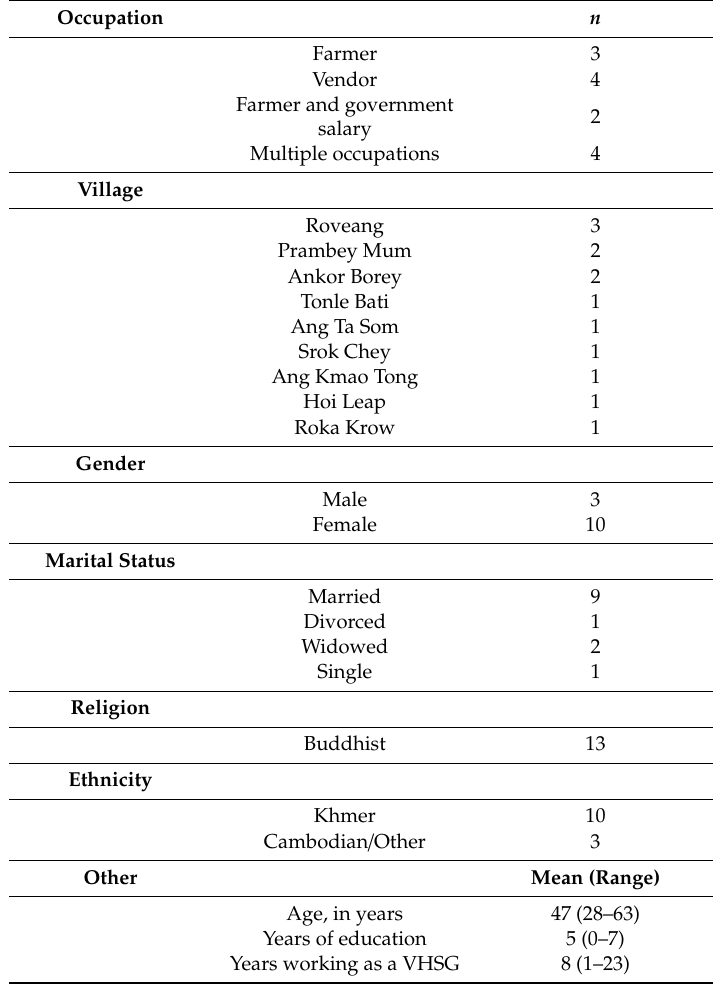
Table 1. Characteristics of interview participants: village health support group (VHSG) volunteers ( N =